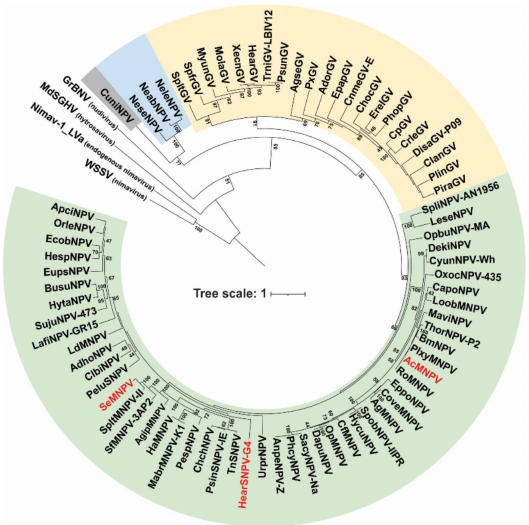
Figure 1. Phylogenetic analysis of the P74 proteins. Evolutionary inference of the P74 protein considering species of the four baculovirus genera and representative species of other invertebrate viruses (nudivirus, hytrosavirus, and nimavirus). Bootstrapping values greater than 40 are shown. Alphabaculoviruses, betabaculoviruses, gammabaculoviruses, and deltabaculoviruses are shaded in green, yellow, blue, and gray, respectively. The three species of alphabaculoviruses considered in the experimental studies are in red